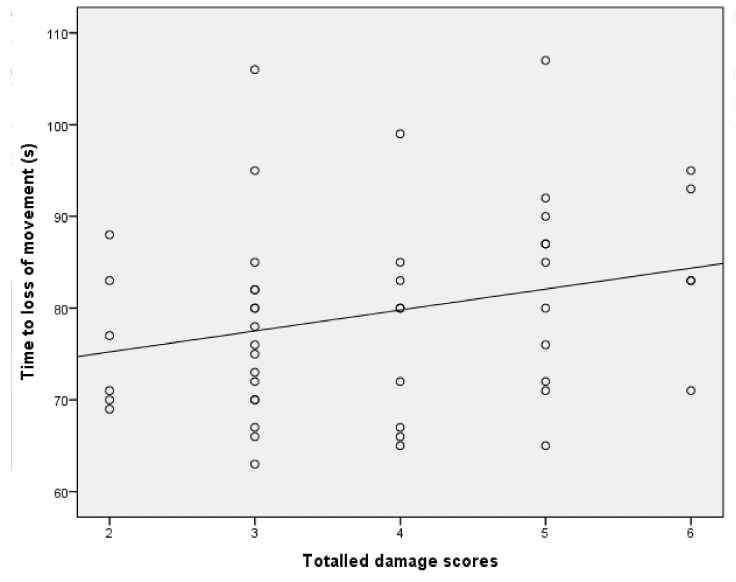
Figure 15. The “trend” for an effect ( p = 0.071) of total macroscopic brain damage on time to loss of movement in lambs.